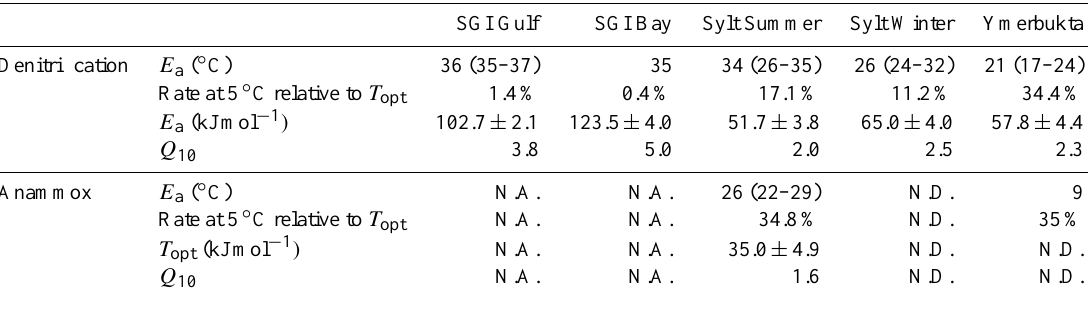
Fig. 3. Potential denitrification rates measured in temperature gradient block experiments for (A) Ymerbukta, (B) Sylt (March 2007), (C) Sylt (June 2007), (D) SGI Gulf, and (E) SGI Bay. The seasonal temperature range is indicated by gray rectangles (note that the seasonal minimum for panel A is − 20 ◦ C). Error bars represent the standard error of the regression slope calculated at each temperature. Note different y axis scaling. Table 3. Optimum temperatures ( T opt ) , apparent activation energy ( E a ) , and ratio of rates at 5 ◦ C relative to T opt for anammox and denitrifi- cation in permeable sediments. The range of the T opt peak where rates did not fall below 90% of the optimum rate is noted in parentheses. Values of Q 10 were calculated between T opt and T opt − 10 ◦